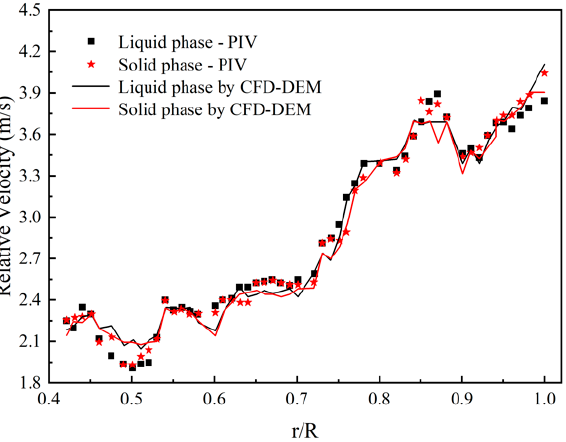
Figure 5. Comparison of the velocities of liquid and solid phases near the pressure side of the blade between the PIV and CFD-DEM